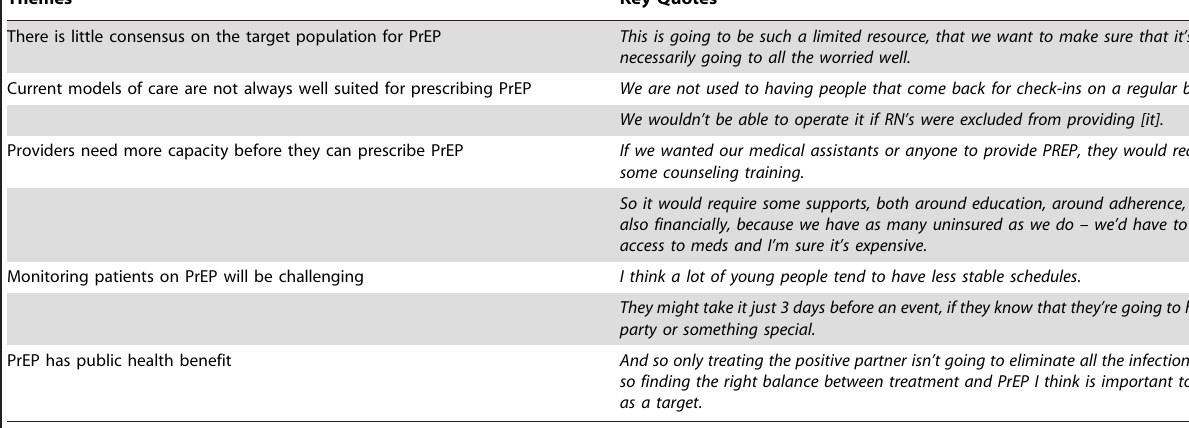
Table 2. Key Themes from